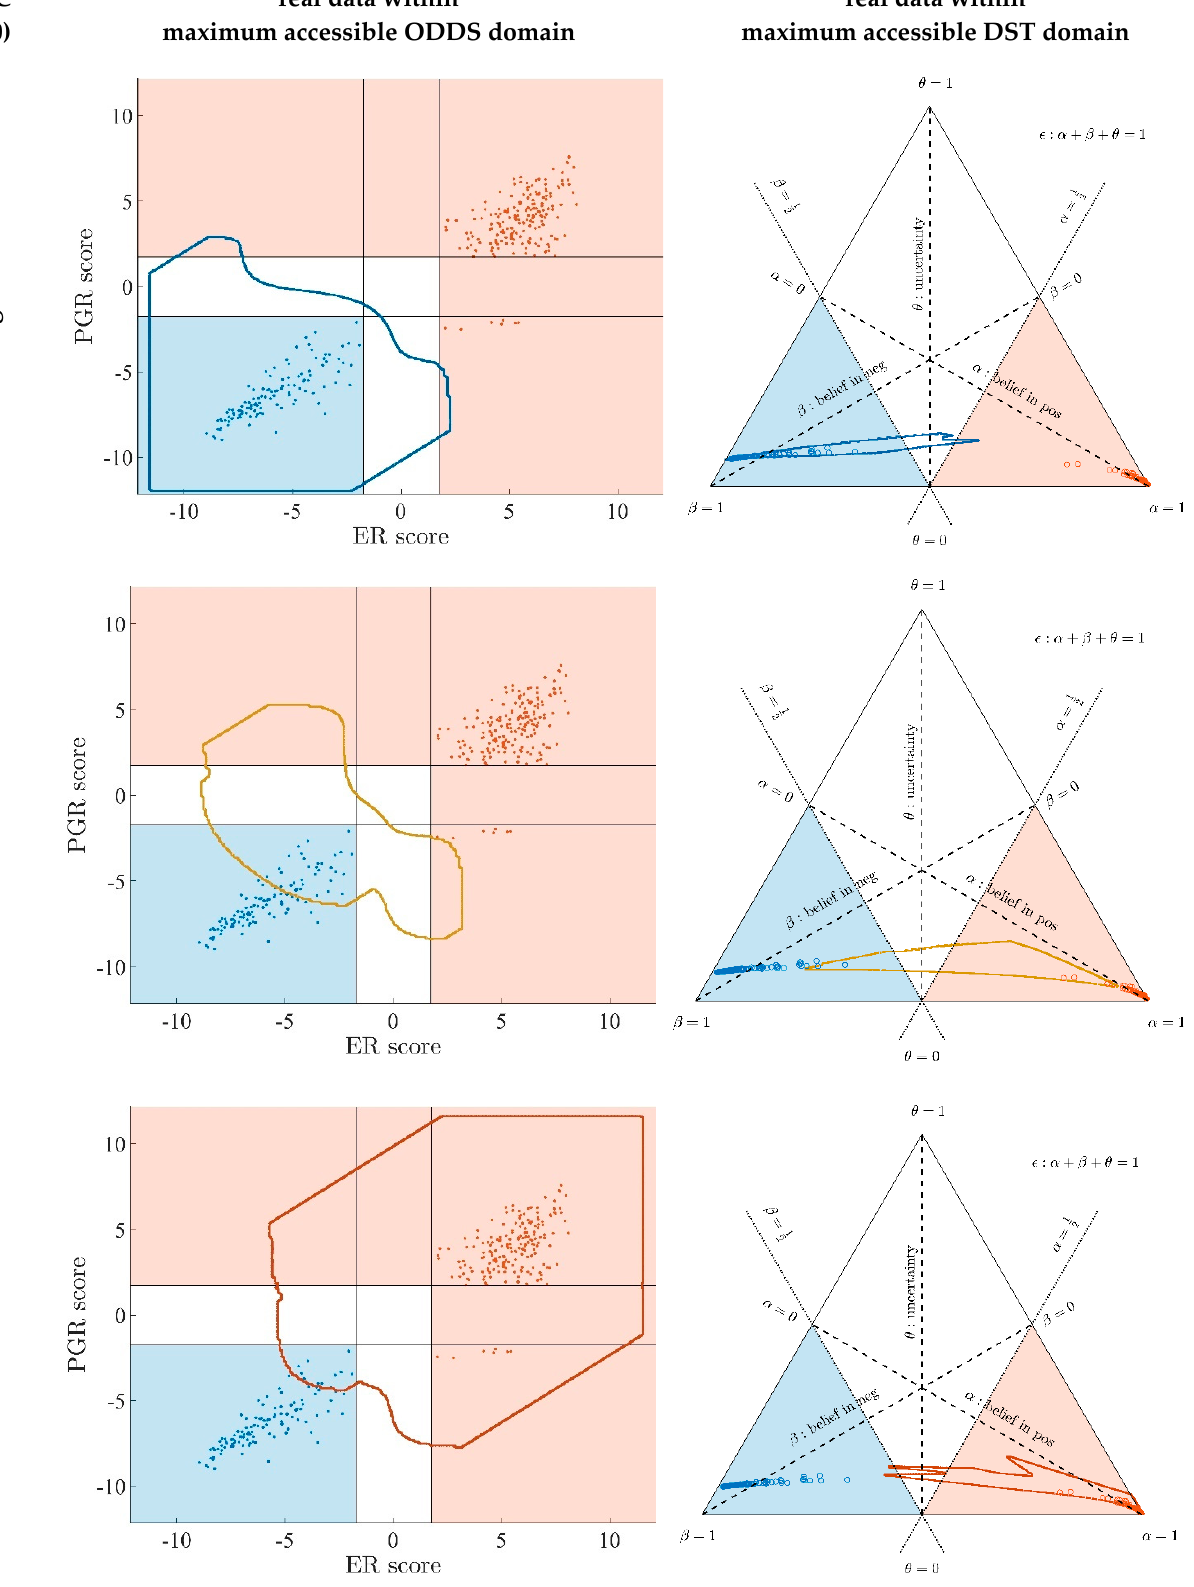
Figure A5. Real sample data within maximum accessible domains for IHC = (+,-). For general fea- tures of display see caption to Figure A3.